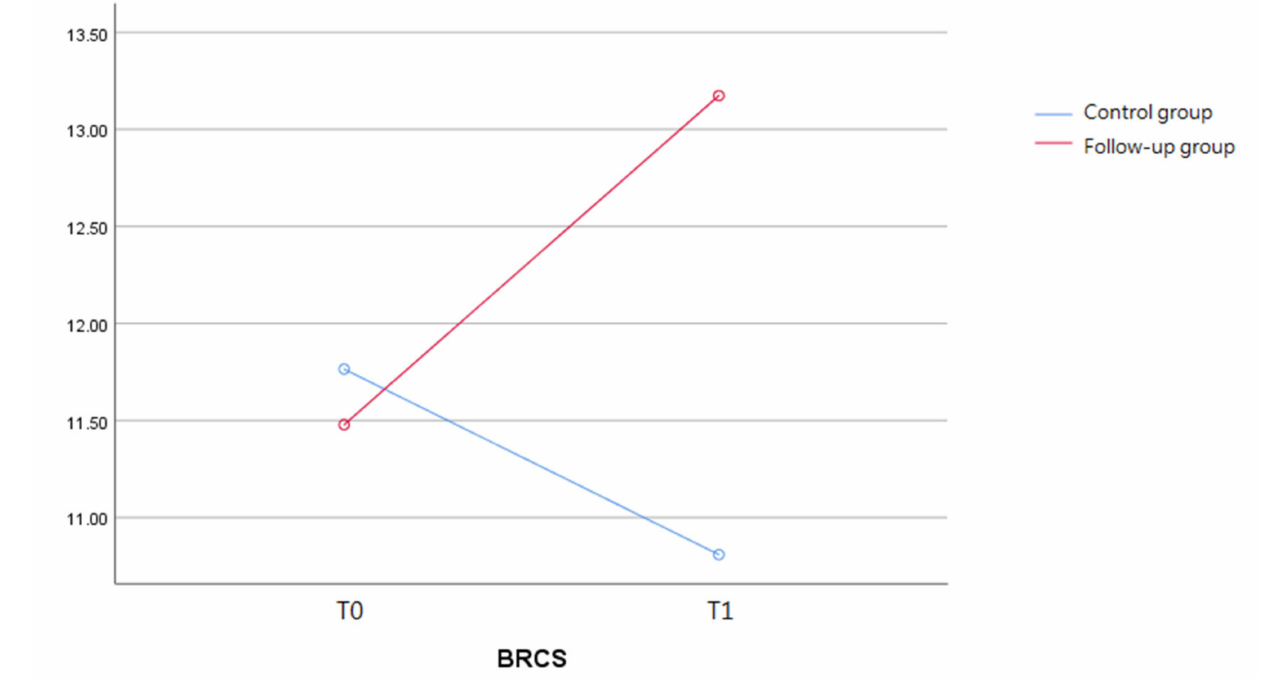
Figure 2. The fluctuations in resilience level across COVID-19 between the two